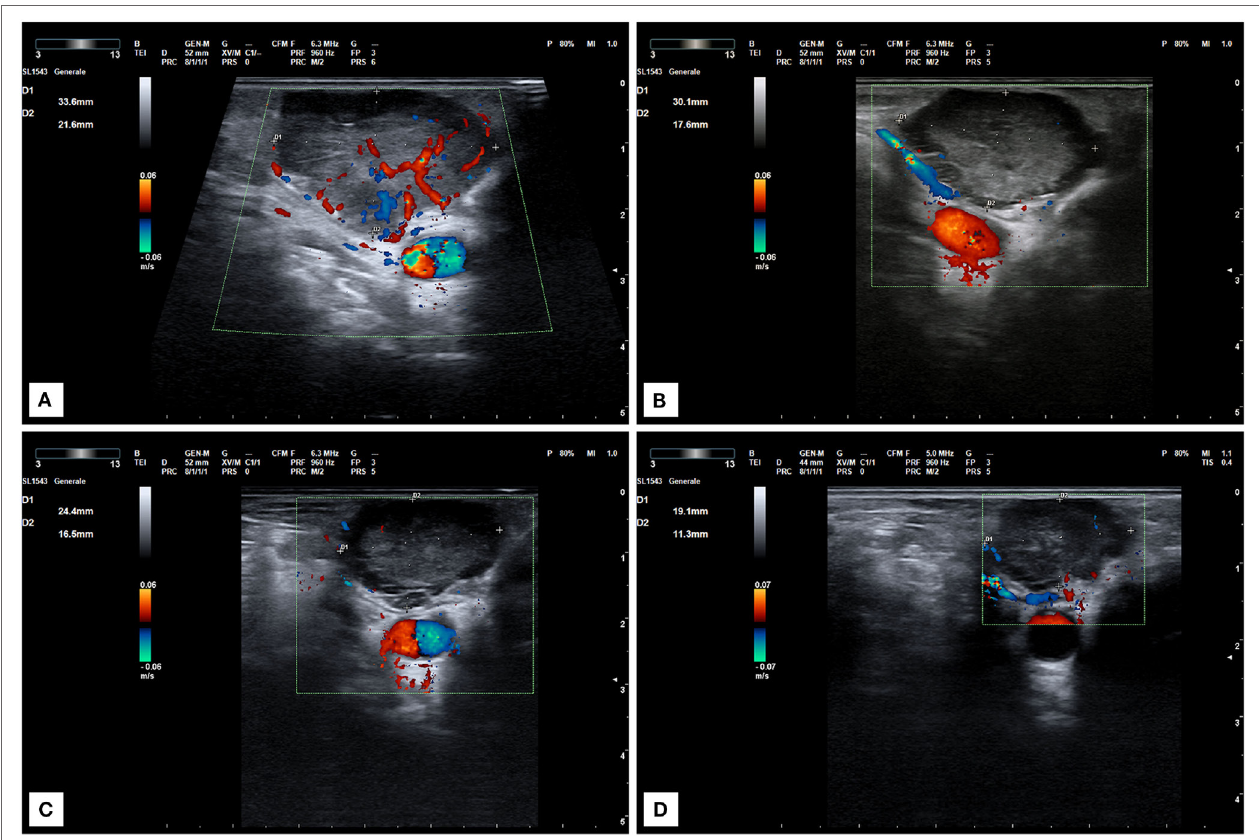
FiGURe 3 | Ultrasound scan of a locally recurrent neck lesion in right supraclavicular region. (a) Imaging before lenvatinib start. (B) Ultrasound scan after 1 month of therapy at 10 mg daily. Tumor vascularization is significantly reduced. (C,D) Progressive tumor reduction after 2 (C) and 6 months (D) of treatment at the same